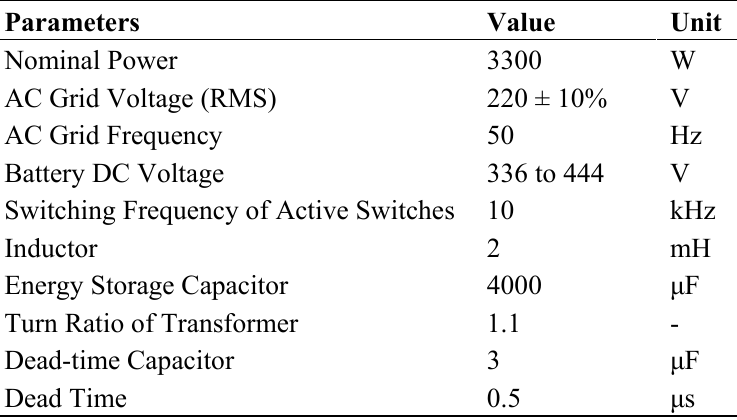
Table 2. Key parameters of the BSS-FBC